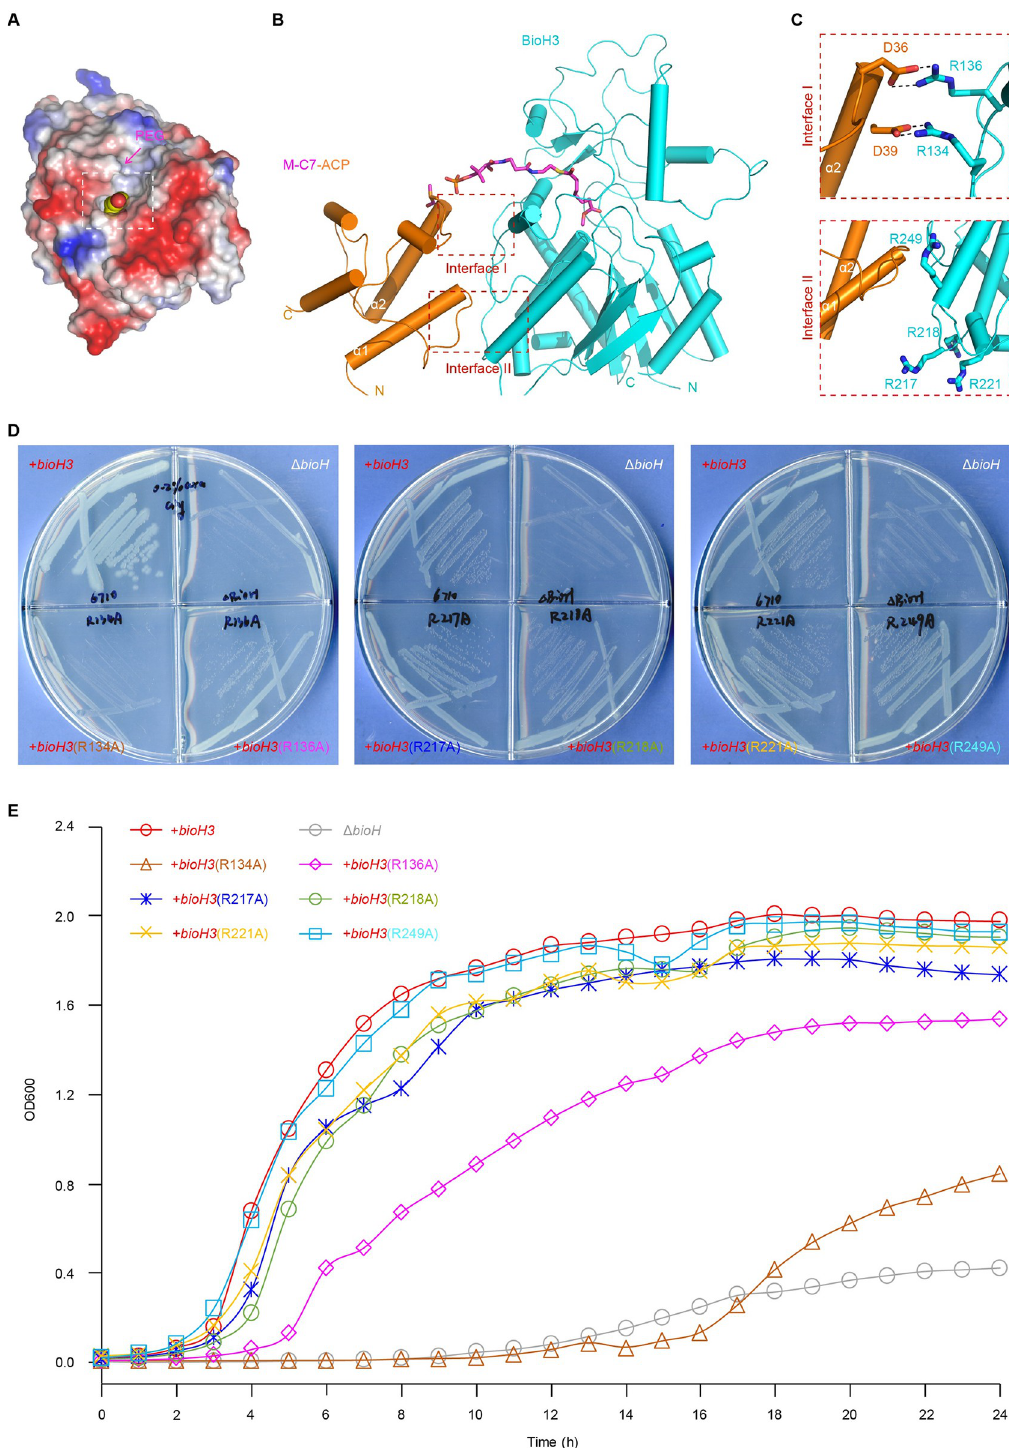
Fig 7. Structure-aided functional insights into recognition of the M-pim-ACP substrate by BioH3. A. Electrostatic surface illustration for BioH3 structure. A PEG-bound tunnel is detected, and highlighted with a dashed line rectangle. The 2F o -F c electron density maps of PEG were contoured at 1.2 δ level. It probably mimics the entry of physiological substrate M-pim- ACP into BioH3 enzyme. B. Structural presentation of BioH3 docked with the methyl pimeloyl moiety of M-C7-ACP. Presumably, the interplay of BioH3 with ACP comprises two interaction interfaces (highlighted with dashed line